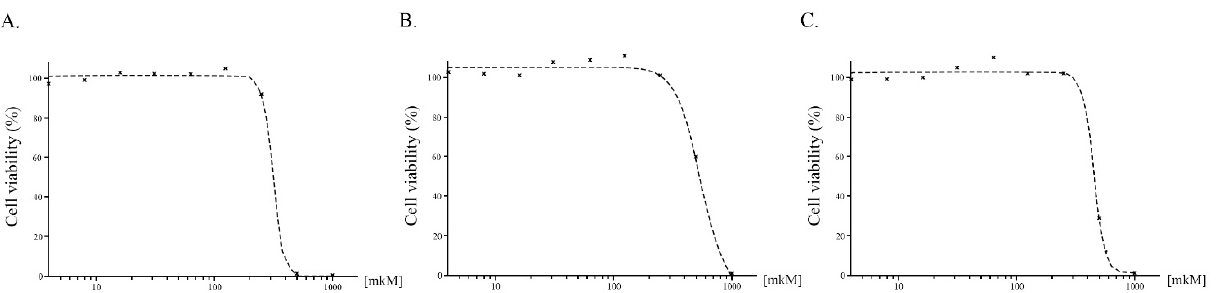
Figure 8. The viability of BJ tert human fibroblasts treated compound 3–5 ( A – C , respectively) for 72 h. The data was normalized to solvent-treated controls. Values are the means ± standard